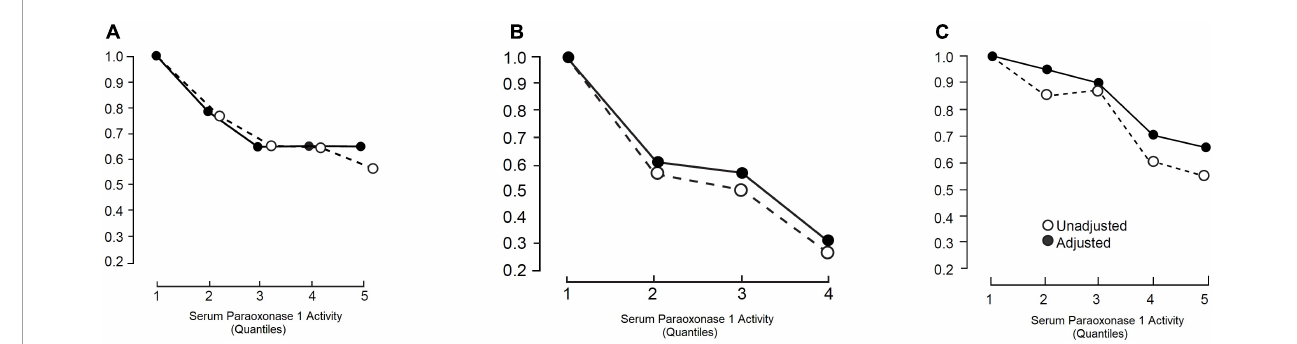
FIGURE2 The risk of ASCVD relative to the lowest risk quartile or quintile (RR) as a function of serum paraoxonase 1 (PON1) activity studied prospectively in (A) Caerphilly and Speedwell (CHD only) (65), (B) cleveland clinic (ASCVD and all-cause mortality) (72), and (C) meta-analysis by Kunutsor et al. (ASCVD) (70). Closed circles are RR unadjusted for other risk factors and open circles after adjustment for some of these (see references for